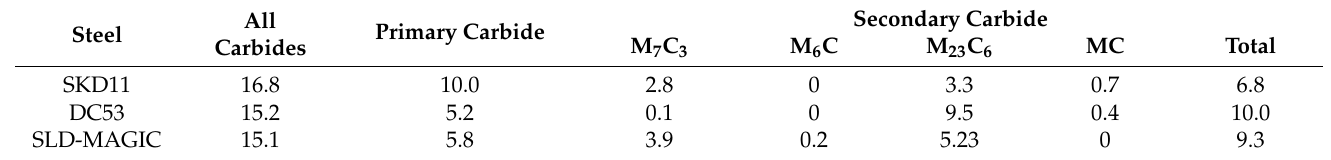
Table 3. Mass fraction of equilibrium phase calculated by JMatPro 7.0 software